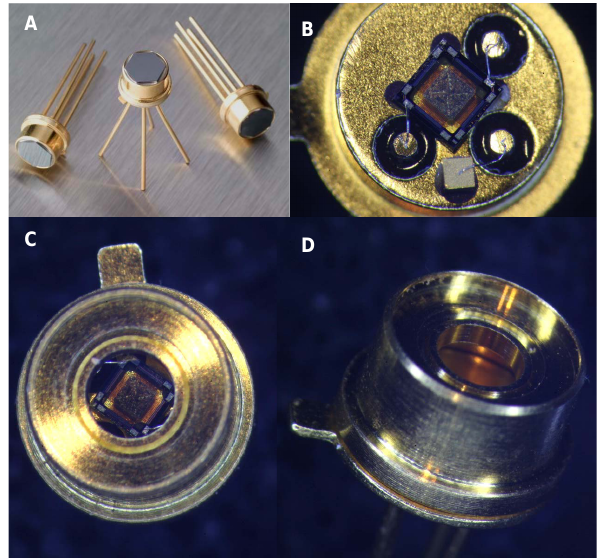
Figure 1. TPS 23B Thermopile sensors. These sensors are a mass product and normally used for IR radiation measurement for exam- ple in ear thermometers. (a) The image on the upper left (courtesy of Excelitas Technologies GmbH & Co. KG.) shows the sensor as it is used for broadband IR detection in applications such as ear ther- mometers. (b) The image on the upper right shows the interior of the device comprising the sensor element with its thermoelements, the (partially transparent) membrane and the IR-absorber patch. A sep- arate thermistor for ambient temperature compensation is located on the bottom of the device. The parts (c) and (d) of the figure show sensors that were manufactured without an IR transparent window. Through the “open window”, the thermopile sensor element is ex- posed to the gas environment. In this study they are used as thermal conductivity gas